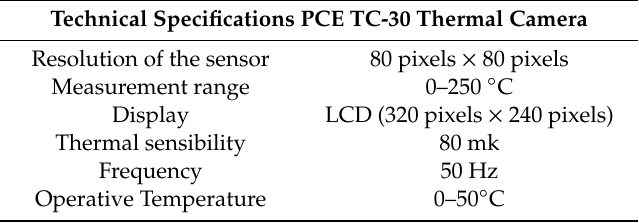
Table 2. Technical specifications of the infrared thermal camera PCE TC-30. Data provided by